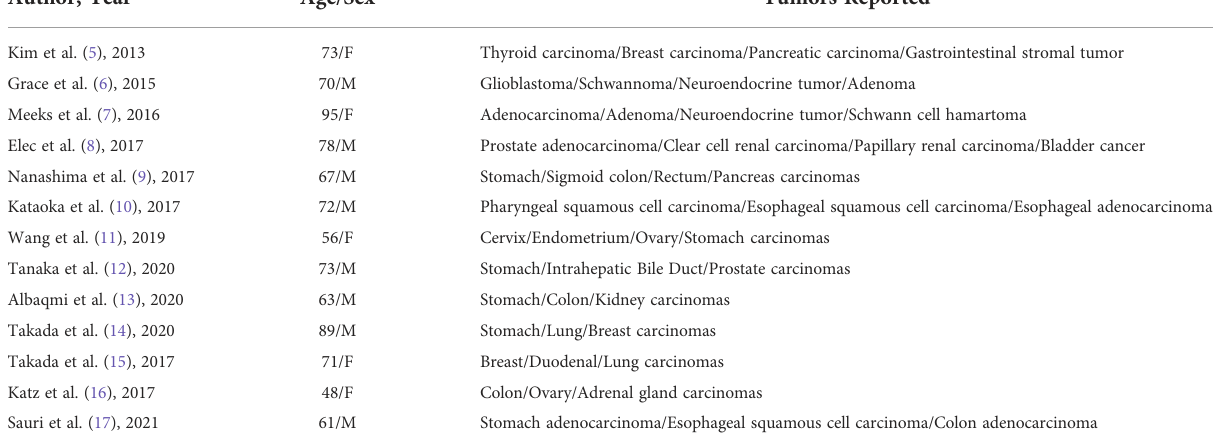
TABLE 1 Summary of cases with multiple primary tumors (three and above) reported in